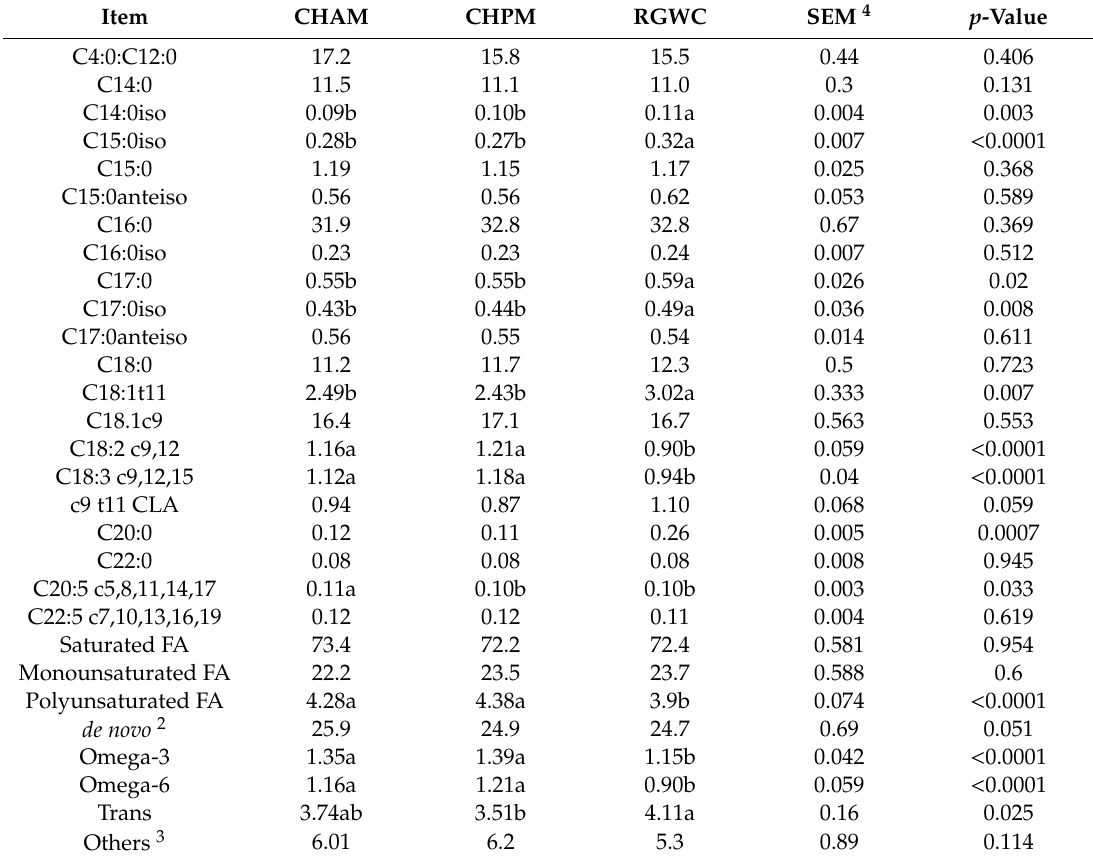
Table 3. Milk fatty acid (FA) composition (g / 100 g of FA) from cows fed CHAM 1 , CHPM 1 , and